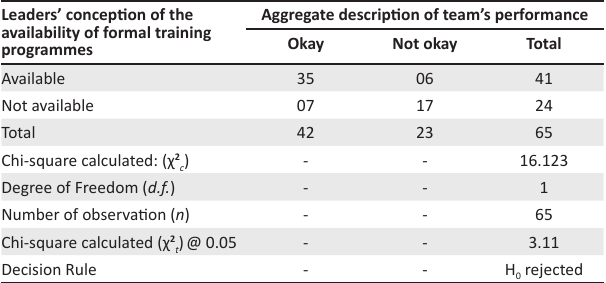
Aggregate description of team’s